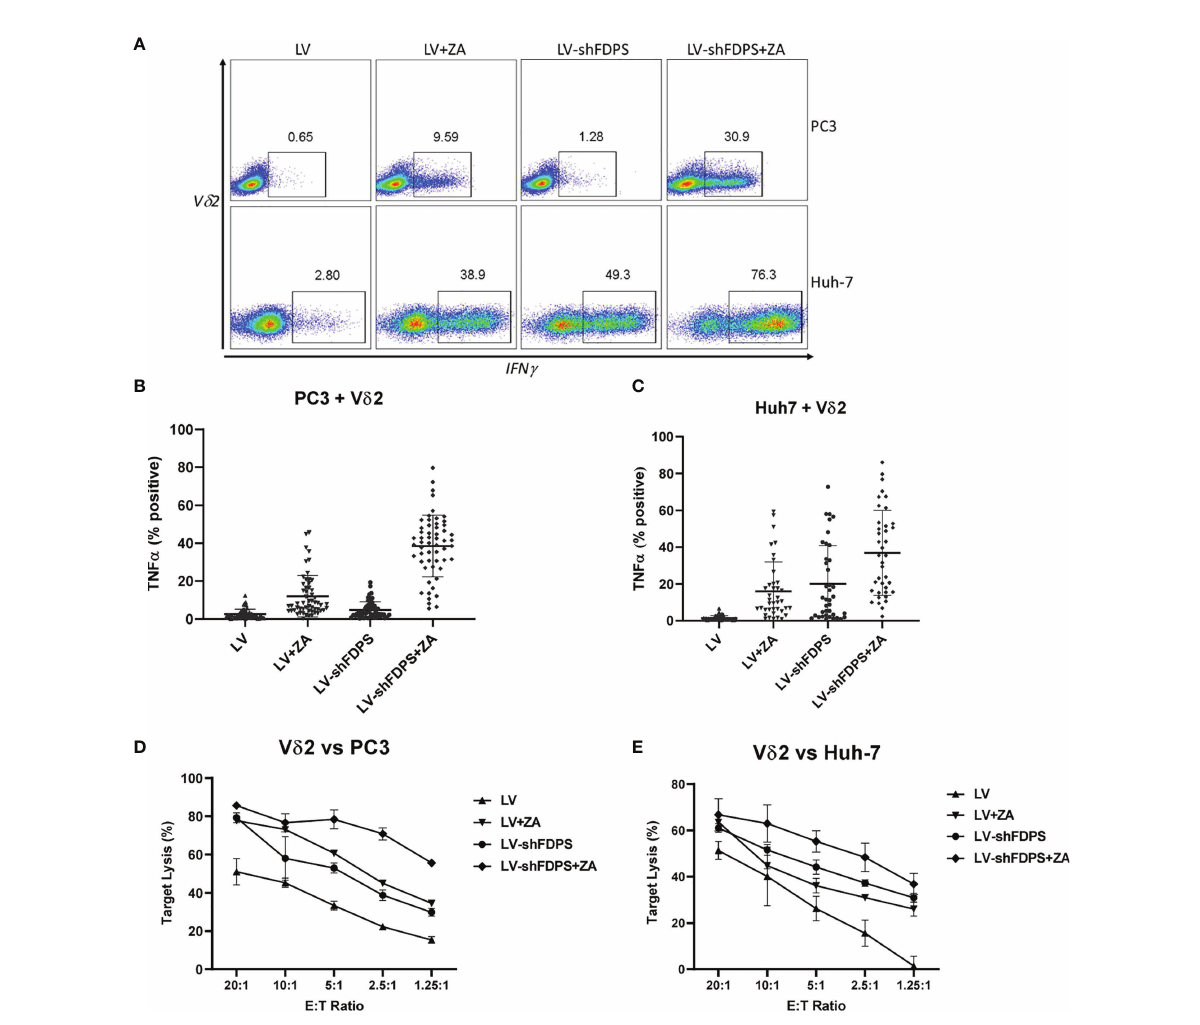
FIGURE 2 V d 2 T cells increase cytokine production and cytotoxic activity when cultured with cancer cells treated with low-dose zoledronic acid (ZA) and transduced with shFDPS. (A) Representative fl ow cytometry dot plots from PC3 and Huh-7 cells transduced with LV-shFDPS in the presence or absence of ZA for overnight, followed by co-culture with V d 2 T cells for 4 h. The gated region indicates the V d 2 and IFN g positive population. In PC3 cells, the percent positive of IFN g producing cells was 9.59 (LV + ZA), 1.28 (LV-shFDPS), and 30.9 (LV-shFDPS + ZA). In Huh-7 cells, the percent positive of IFN g producing cells was 38.9 (LV + ZA), 49.3 (LV-shFDPS), and 76.3 (LV-shFDPS + ZA). (B, C) LV-shFDPS transduced PC3 and Huh-7 cells were treated either with or without ZA for overnight, followed by co-culture with V d 2 T cells for 4 h. The cells were analyzed by fl ow cytometry for V d 2 and TNF a expression. The data represents a summary of assays using V d 2 T cells from multiple donors (PC3, N=56; Huh-7, N=39). Each dots represents the percentage of V d 2 and TNF a positive cells from an individual donor. In PC3 cells, the percent positive of TNF a producing cells was 12 ± 10.9% (LV + ZA), 4.8 ± 4.3% (LV-shFDPS), and 38.6 ± 16.3% (LV-shFDPS + ZA). In Huh-7 cells, the percent positive of TNF a producing cells was 16.1 ± 15.9% (LV + ZA), 20 ± 10.8% (LV-shFDPS), and 36.9 ± 23.1% (LV-shFDPS + ZA). (D, E) LV or